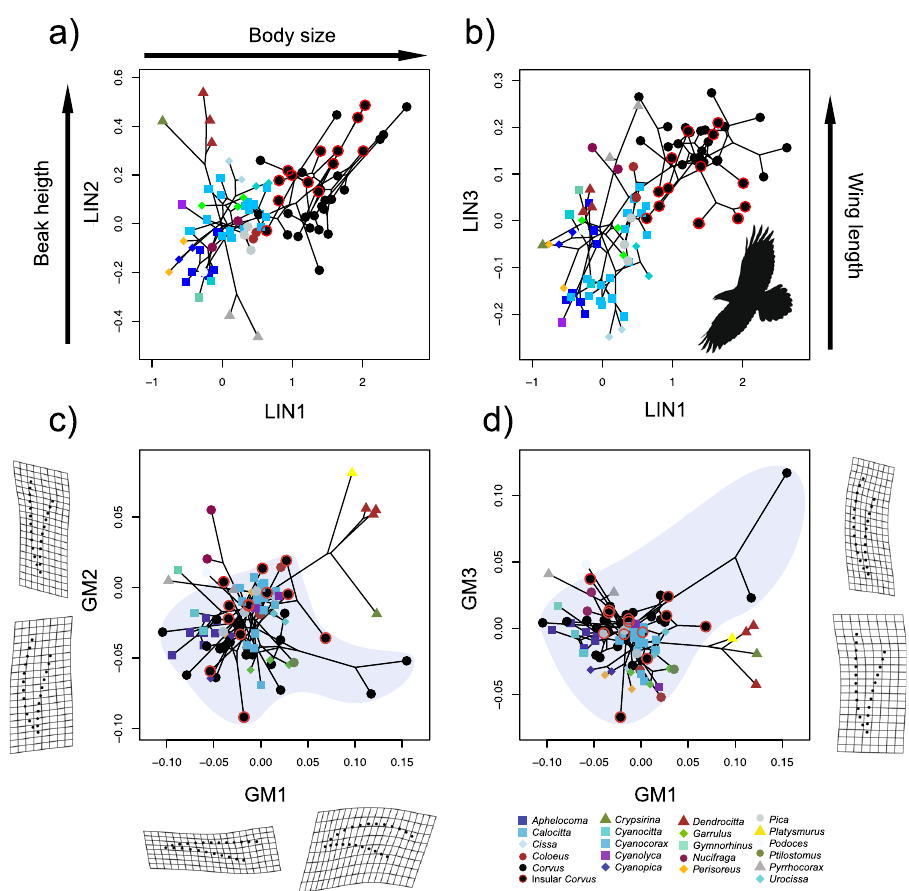
Fig. 3 Morphological diversity in the family Corvidae. Upper panels a , b depict the morphospace derived from a phylogenetic PCA on linear measurements. Lower panels c , d depict the morphospace of beak shape derived from a phylogenetic PCA on data obtained through geometric morphometrics. Black lines depict phylogenetic relationships among species. Blue regions highlight the extent of the beak morphospace occupied by Corvus . Peripheral graphs in the bottom panels depict thin-plate spline deformation grids to help visualise extreme shapes along each